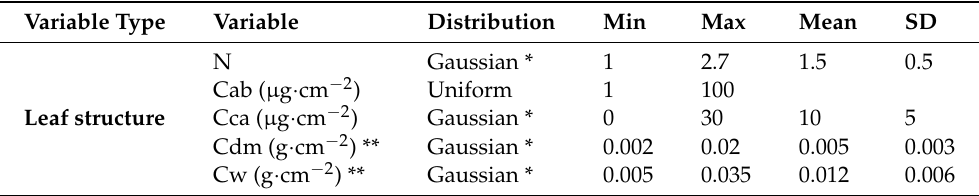
Table A1. The used ranges for the input variables of the SCOPE model. N: leaf mesophyll